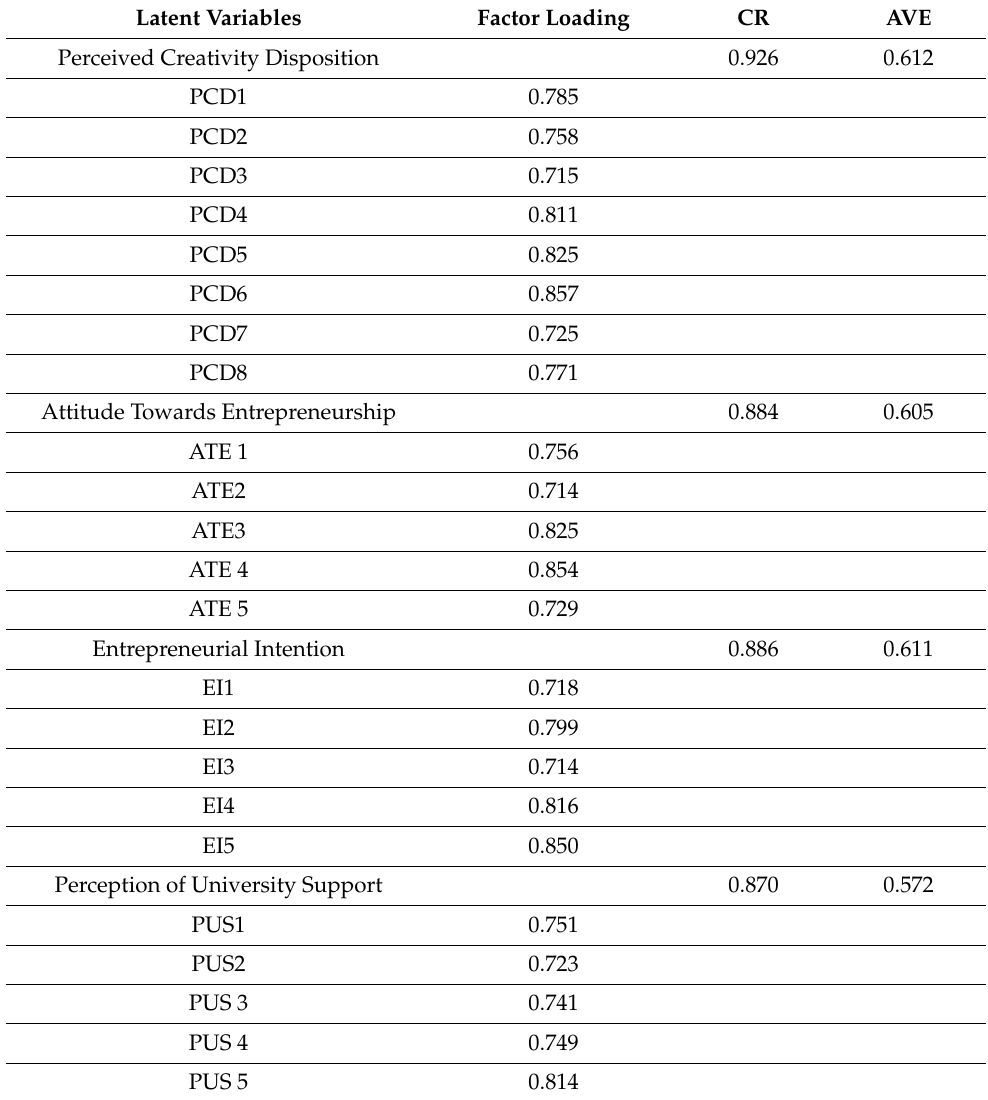
Table 1. Measurement model (FL, CR, and AVE).